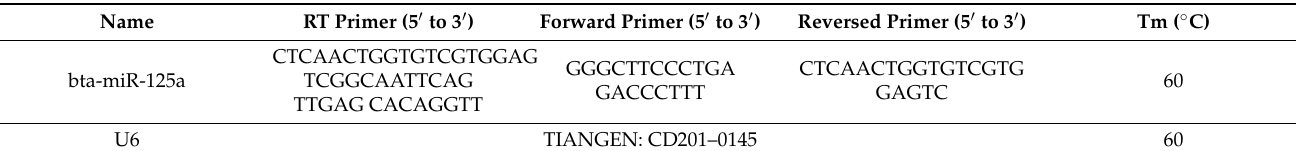
Table 1. Primer sequences for qPCR.